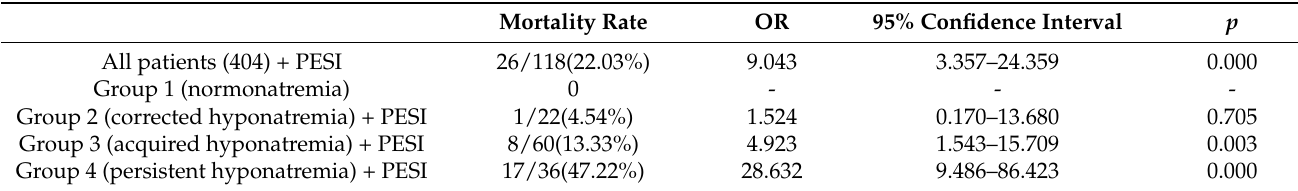
Table 4. Association between hyponatremia and high Pulmonary Embolism Severity Index (PESI) regarding mortality in patients with pulmonary embolism (PE).